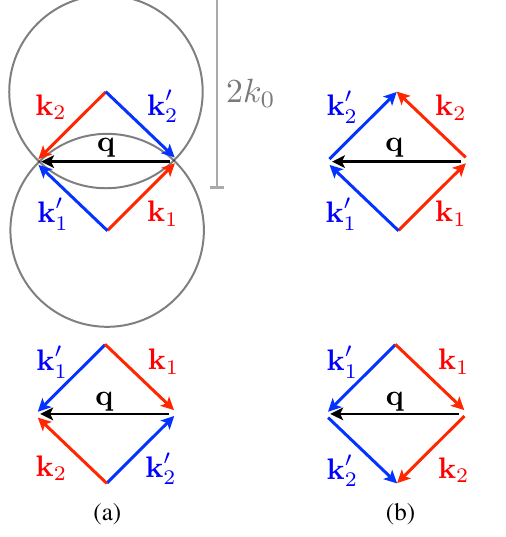
FIG. 9. Coulomb two-particle scattering processes k 1 ; 2 → k 0 k q , for given exchanged momentum q in the 1 ; 2 (cid:2) 1 ; 2 ¼ α → ∞ limit, where all particle momenta are constrained to a ring of radius k 0 . For q ≠ 0 , only four interaction processes are possible, which can be grouped into two classes: (a) BCS-like scattering of a pair of opposite-momentum states k 1 ¼ − k 2 into another pair with k 0 1 ¼ − k 0 2 and (b) exchange-type scattering processes ð k 1 ; k 2 Þ → ð k 0 1 ¼ k 2 ; k 0 2 ¼ k 1 Þ